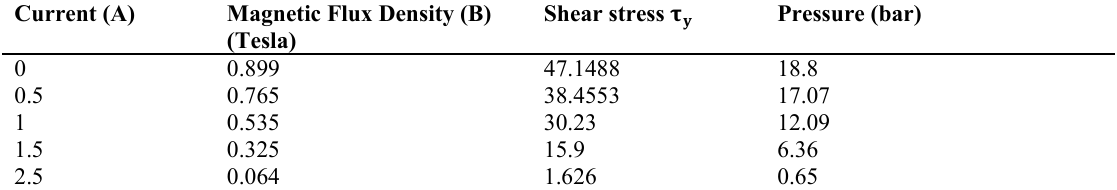
The relation between current, magnetic flux intensity, pressures, and shear stress to MR Valve Current